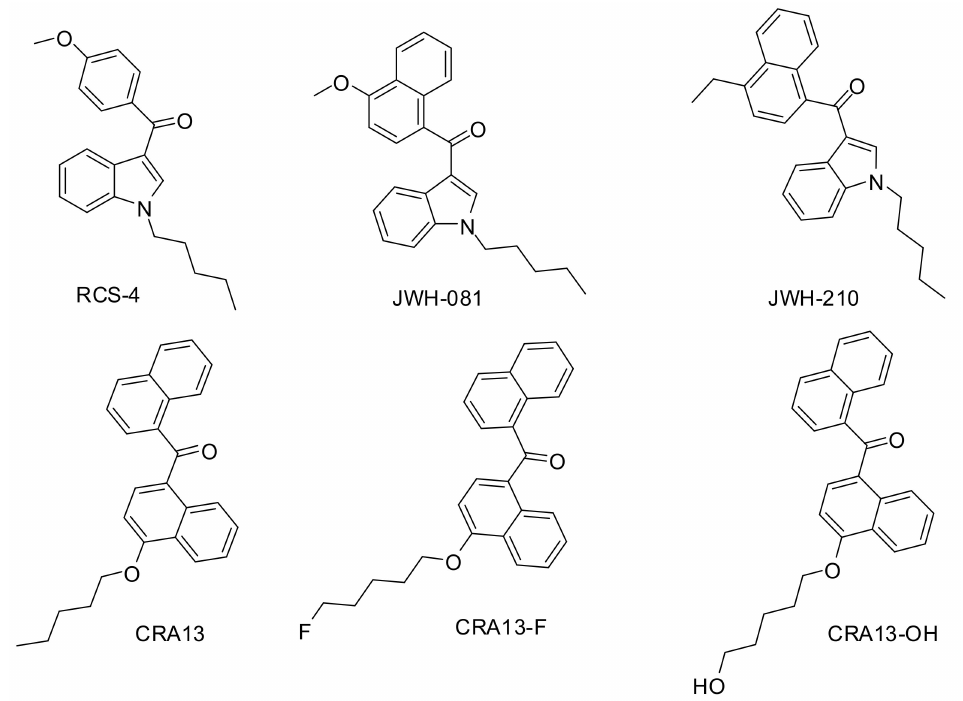
Figure 1. Structure of phytocannabinoid tetrahydrocannabinol (THC) and the synthetic cannabinoids used in this